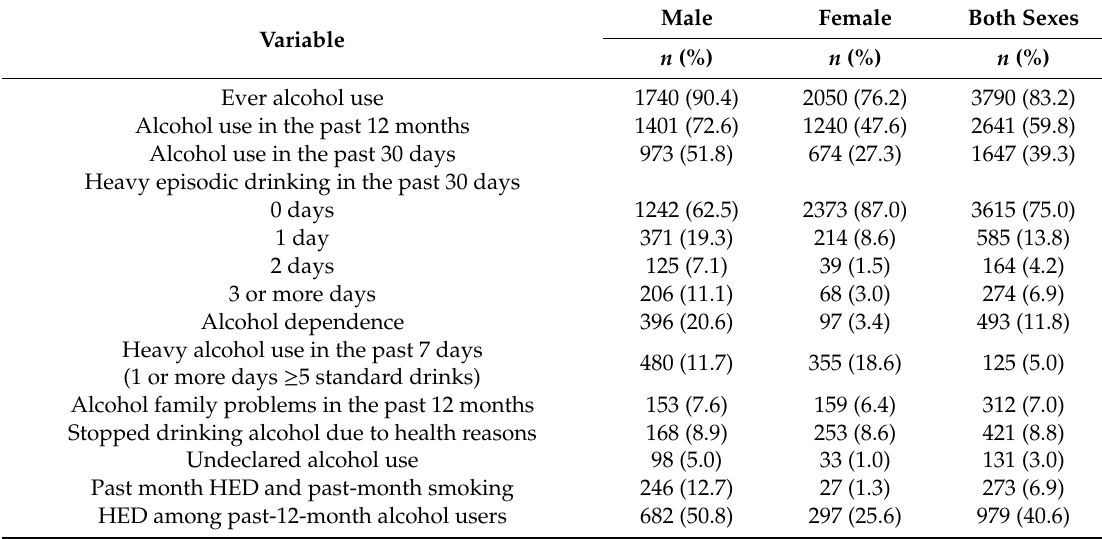
Table 2. Distribution of alcohol use pattern among adults in Ecuador,